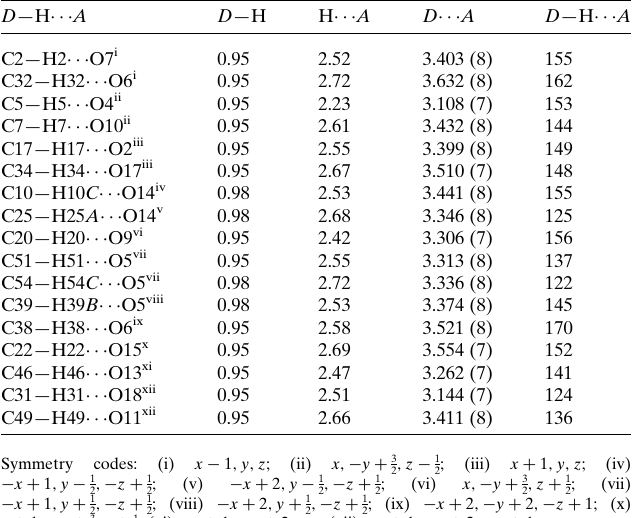
Table 2 Experimental details. Crystal data Chemical formula Crystal system, space group